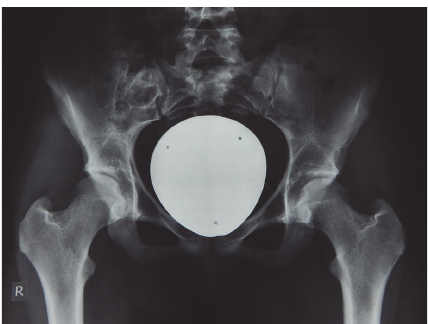
Figure 1: Plain radiograph of the pelvis, initially erroneously diagnosed as normal. Retrospectively, asymmetry of the SIJ is observed which was originally misdiagnosed as bowel gas.